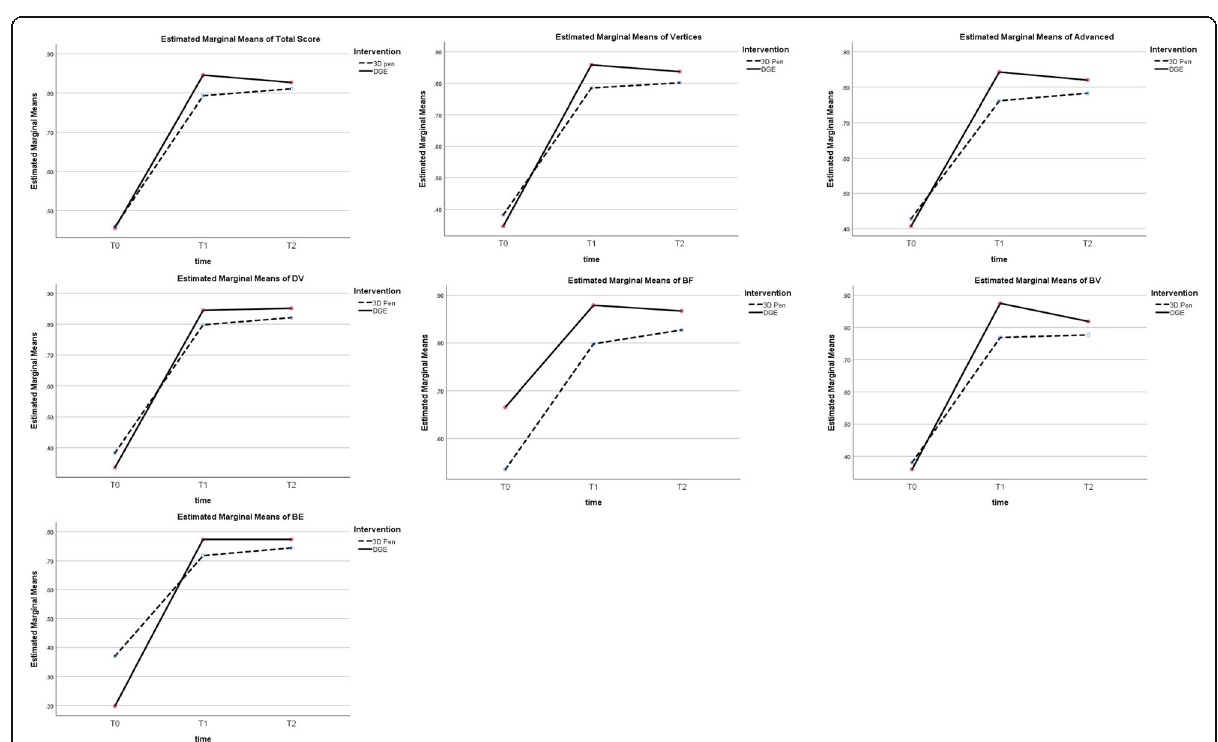
Fig. 2 Development of T0, T1, and T2 scores on the total score, vertices, advanced, SV, AF, AV, and